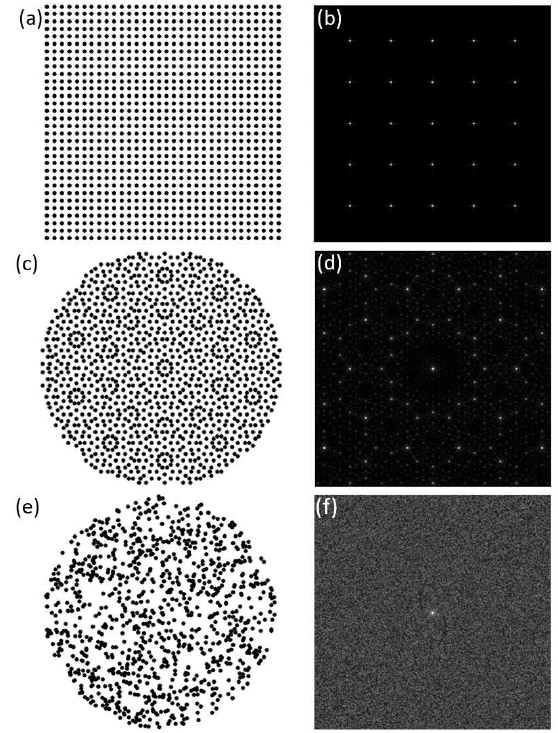
Figure 1. ( a ) N = 1024 square array, and its diffraction pattern in ( b ); ( c ) N = 1108 Penrose array, and its diffraction pattern in ( d ); ( e ) N = 1000 pseudo-random 2D array, and its diffraction pattern in ( f ). The diffraction patterns are created with S λ 2 = 0.126, in an angular range of 80 degrees. The third root of the diffraction pattern is plotted for better